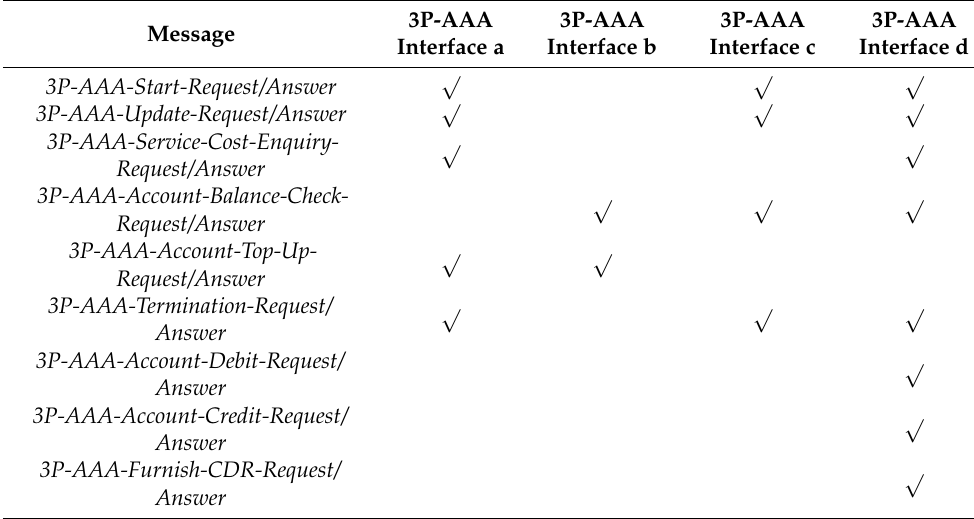
Table 1. The main signaling protocol messages over the four new 3P-AAA interfaces.